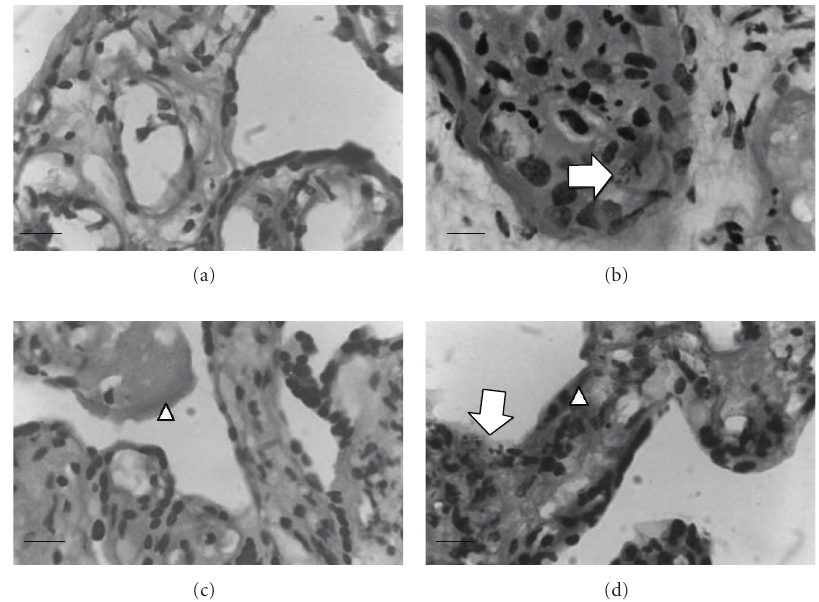
Figure 1: Para ffi n-embedded placental villi cultured for 48 hs, Pas/H stained. (a) Control placental villi without T. cruzi infection cultured with normal glucose concentration media; (b) normal placental villi in vitro infected with T. cruzi, cultured with normal glucose media; (c) normal placental villi cultured under high glucose concentration media; (d) normal placental villi cultured under high glucose concentration media, in vitro infected with T. cruzi. Amastigotes nests were observed inside the villous from infected placentas (arrows). Arrow points indicate increased glycogen deposits in placental villi explants cultured under HG concentration (c and d). Original magnification: 1000x. The scale bar represents 1 µ